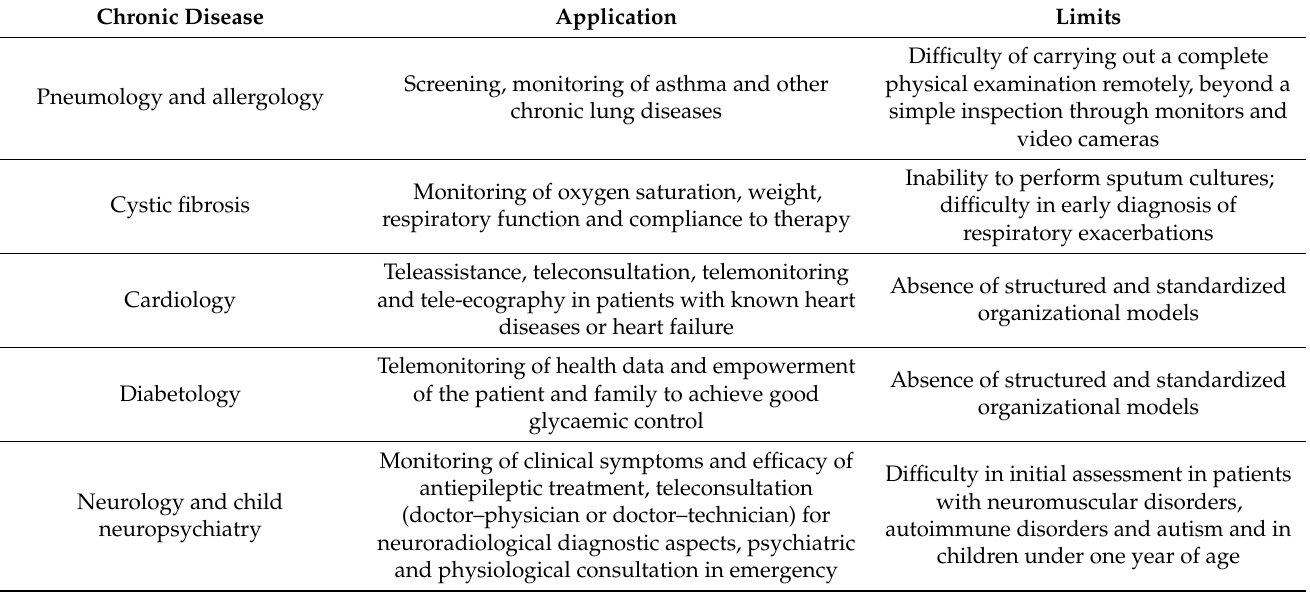
Table 4. Telemedicine in children and adolescents with chronic